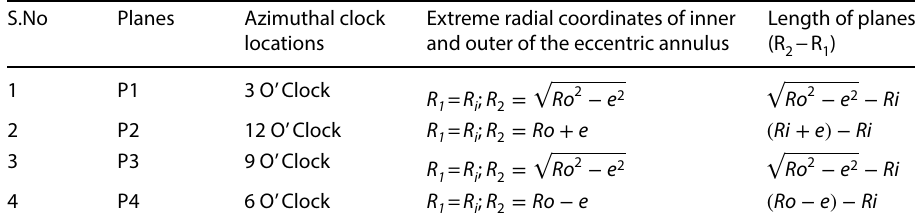
** Extreme radial coordinates (R1 & R2) of different planes have been measured by taking the center of the inner circle as